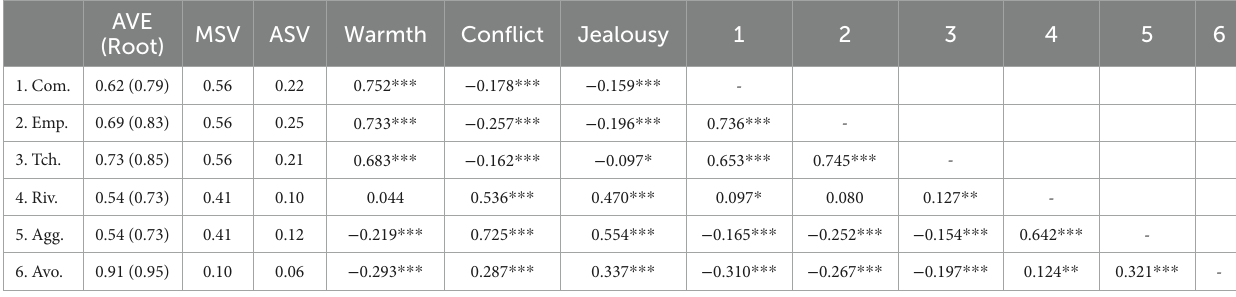
TABLE 4 Convergent, discriminant, and criterion validity.